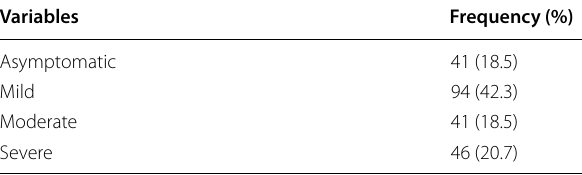
Table 3 Severity of COVID-19 patients ( n